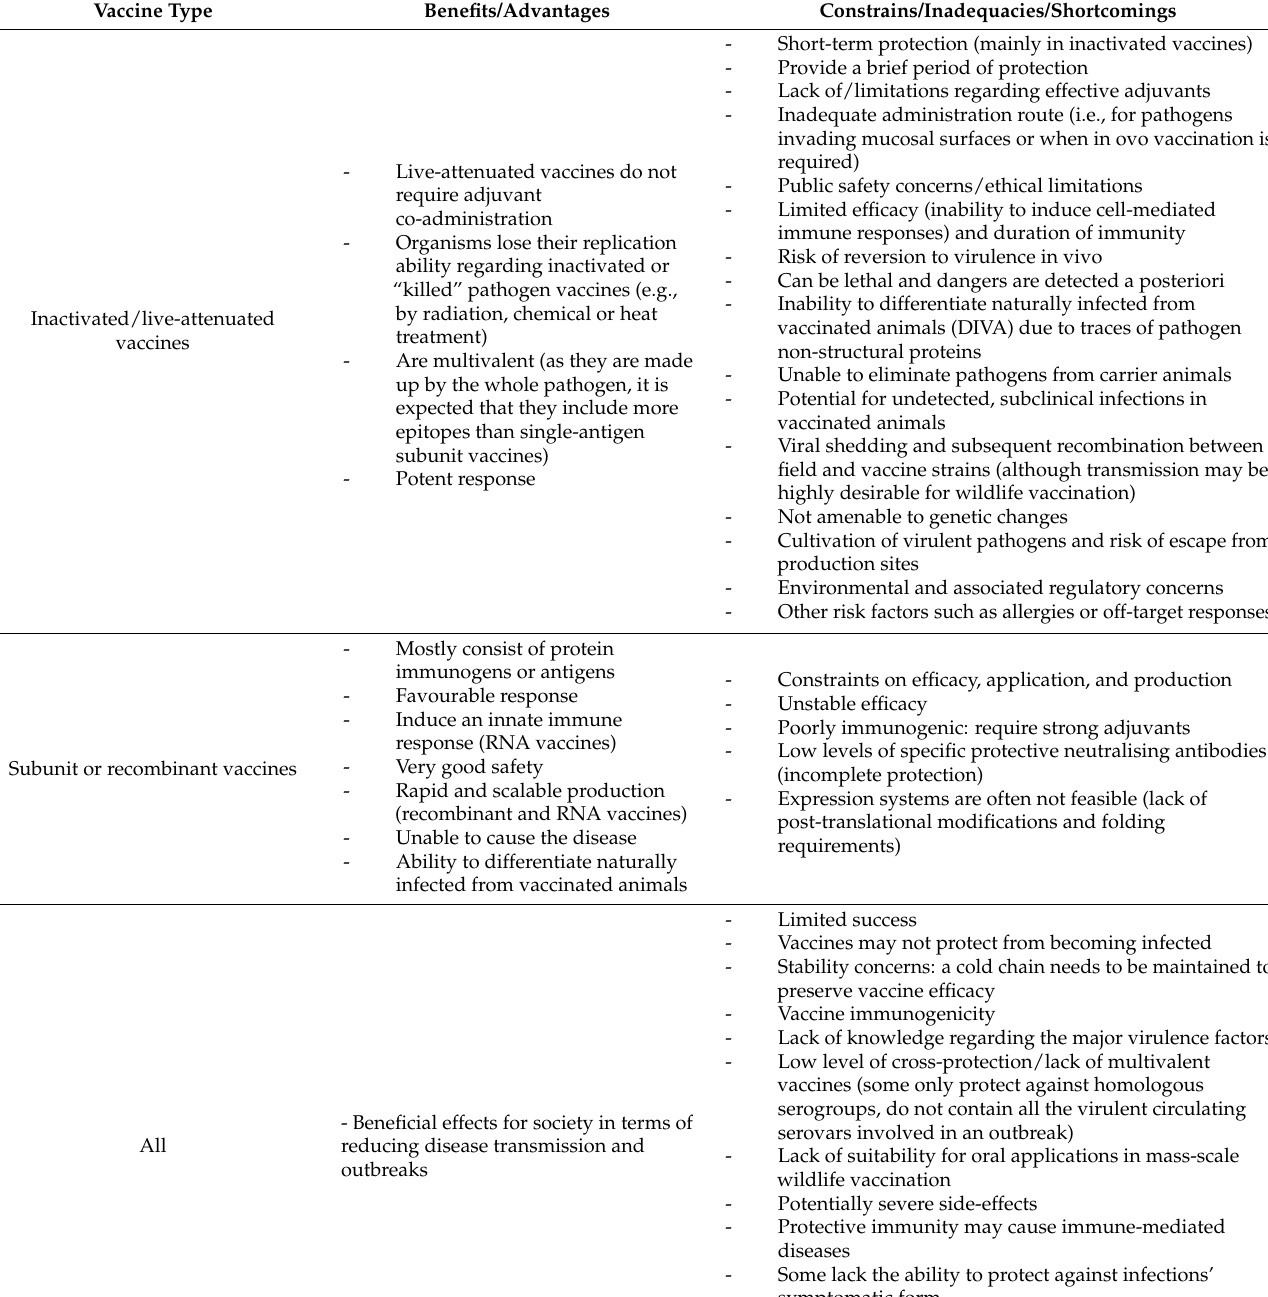
Table 1. The main challenges of many commercial/in development vaccines for their practical application. Vaccine